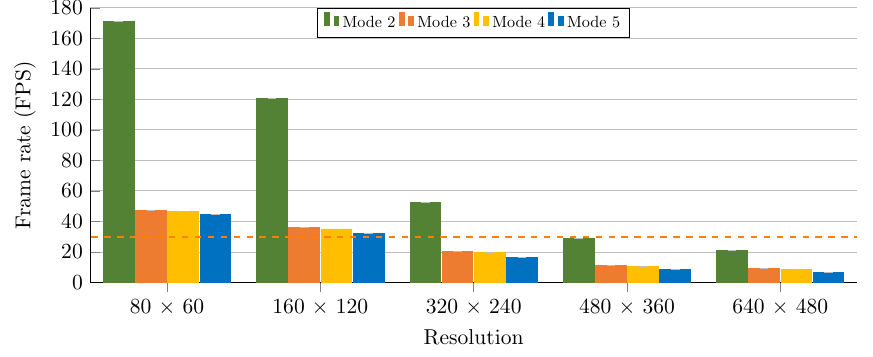
Figure 21. Output frame rate of each mode. The orange line represents the real time threshold of 30 Frames Per Second (FPS). The gray lines indicate the confidence